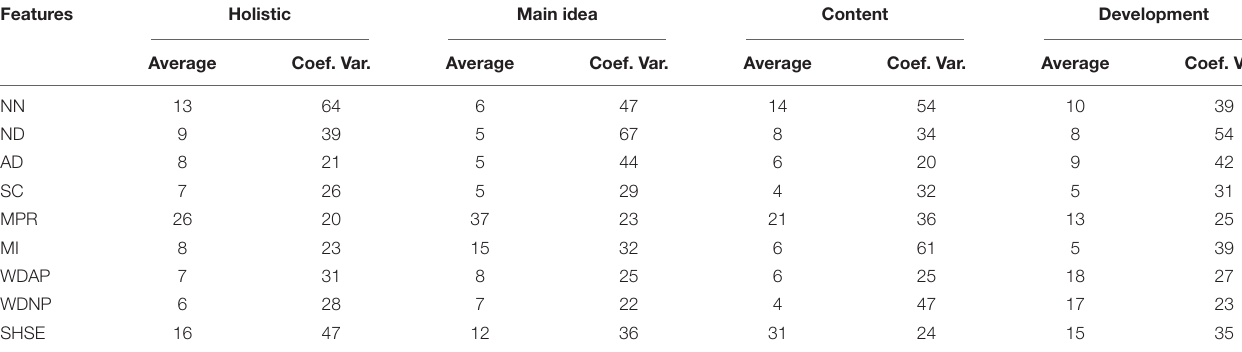
TABLE 7 | The relative importance of features (expressed as percent of total weights) from regression for the prediction of H1. Features Holistic Main idea Content Development Coef. Var. Average Coef. Var. Coef. Var.